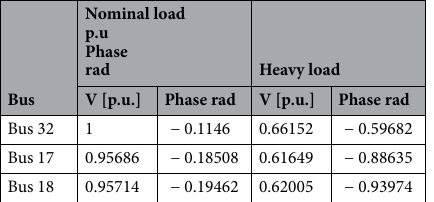
Table 11. Power flow result of the system with STATCOM installed.